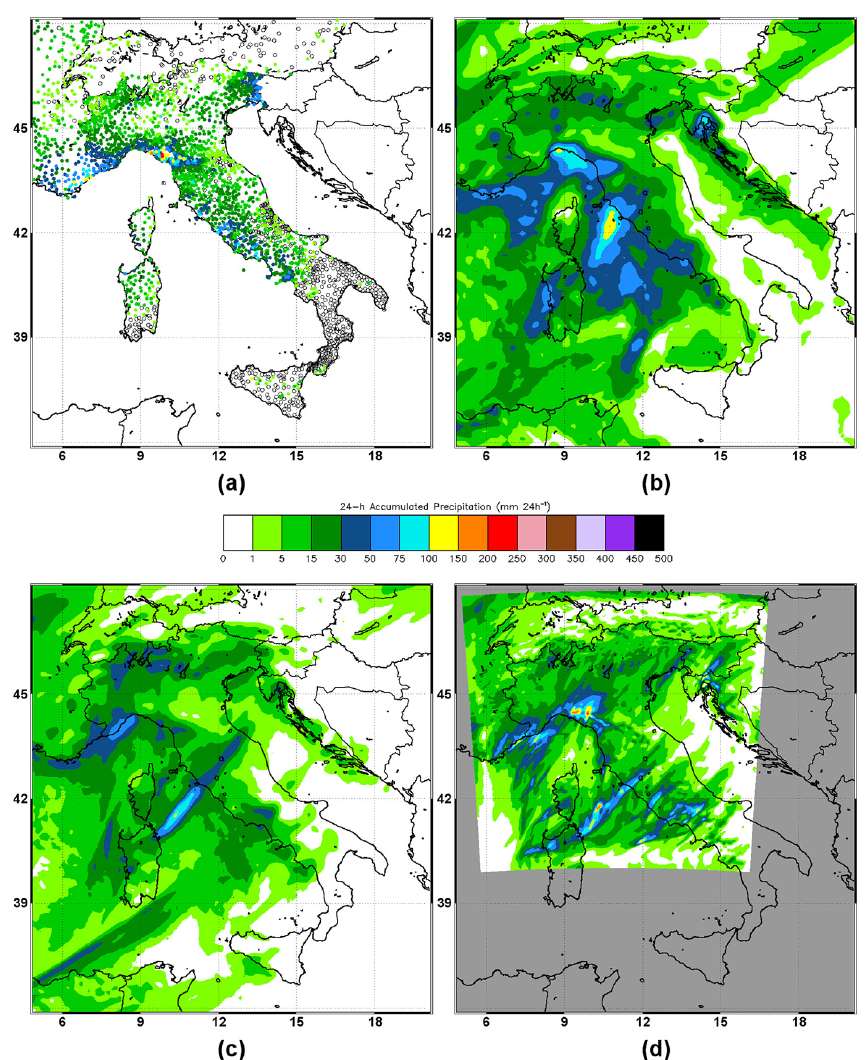
Figure 8. 24h accumulated precipitation on 26 October 2012. Focus over Italy: (a) rain gauge observations; (b) 0.1 ◦ BOLAM forecast from the operational SIMM; (c) 0.07 ◦ BOLAM forecast from the HyMeX-based SIMM; (d) 0.0225 ◦ MOLOCH forecast from the HyMeX-based SIMM (where the area external to the model domain is shaded in grey). The forecasts were initialised at 12:00UTC of 25